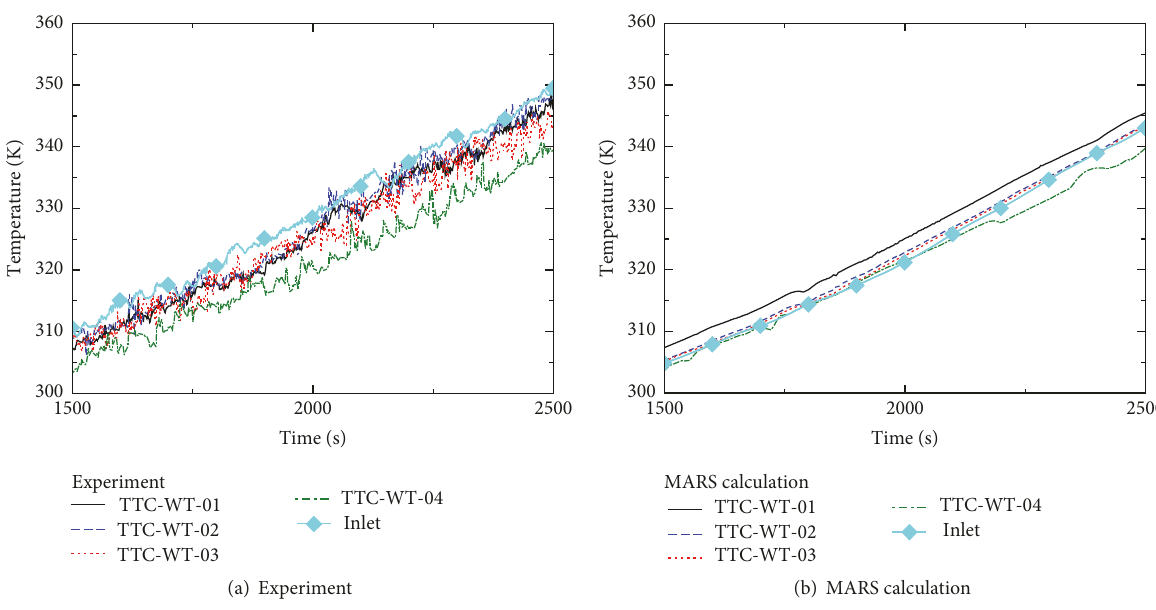
Figure 16: Temperature behaviors in the water tank from 1500 s to 2500 s for Case 4-1.